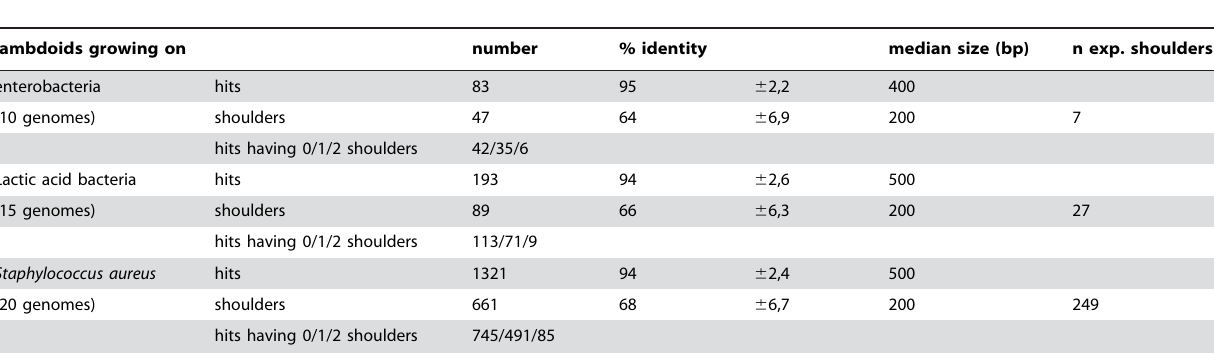
Table 3. Analysis of homeologous regions (shoulders) at the border of recombination tracks (hits) in three lambdoid families.